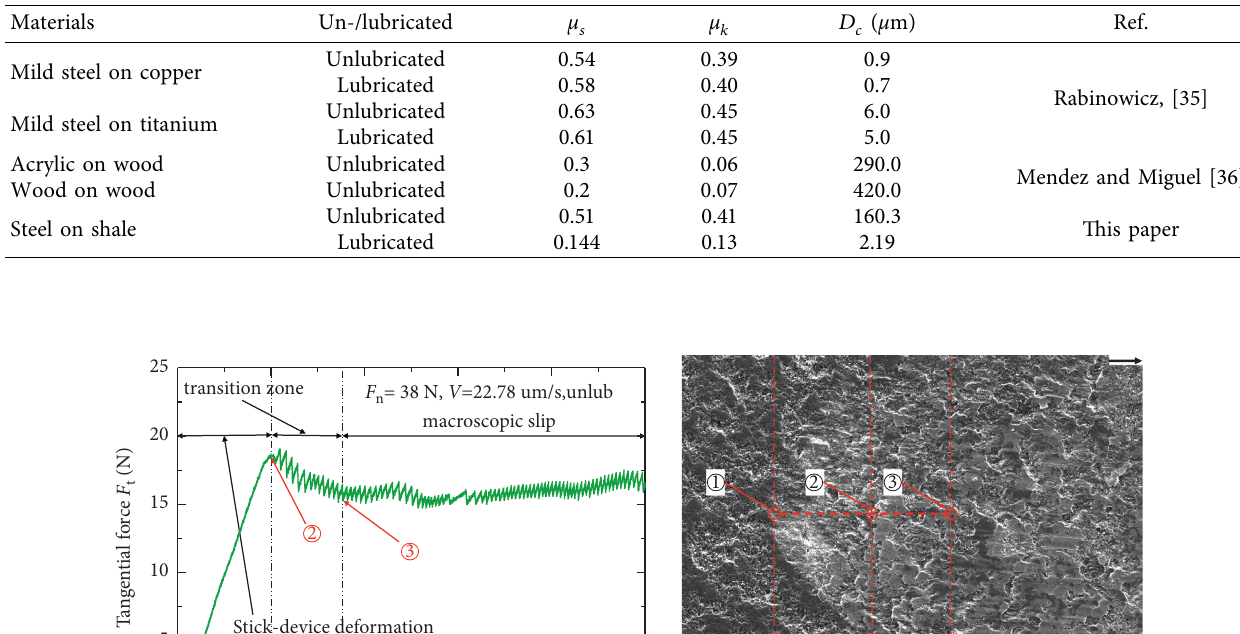
Table 3: Values of D c for different materials [36, 38].